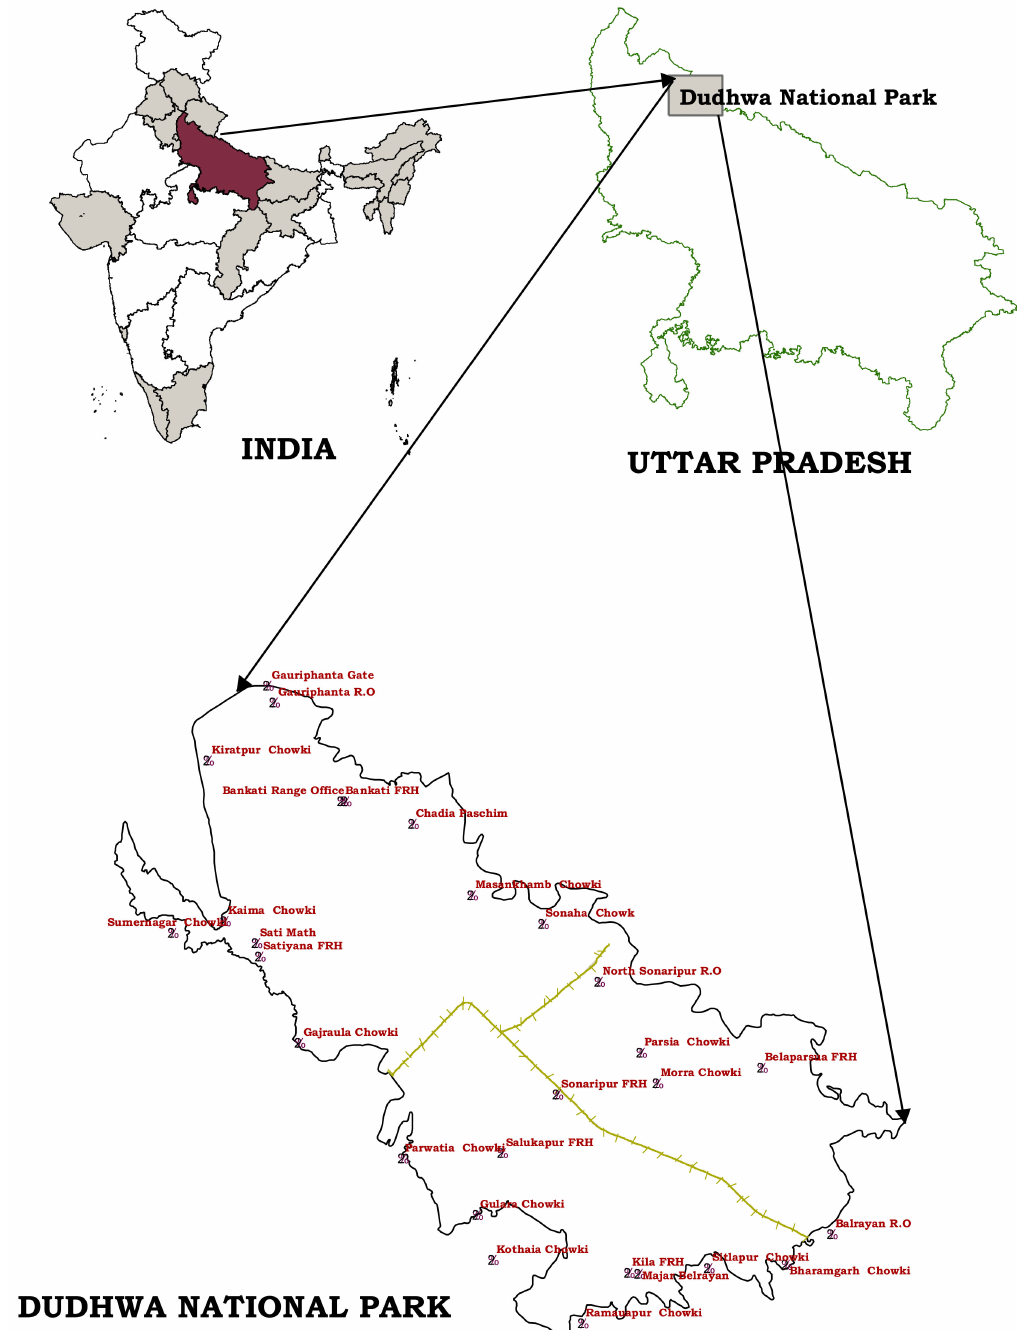
Figure 1. Location of the study